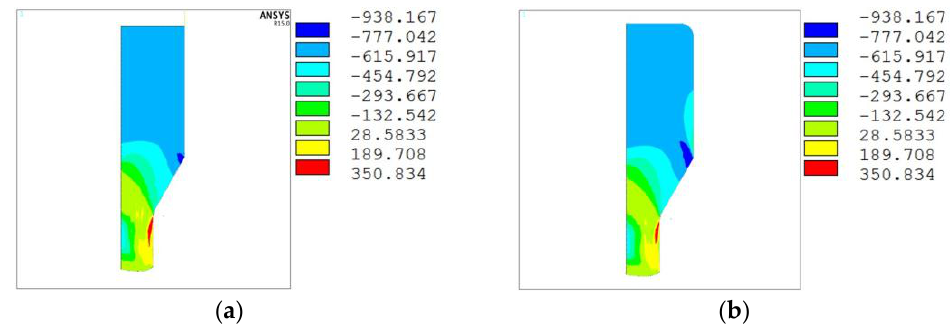
Figure 5. Axial distribution of ( a ) displacement-load model and ( b ) pressure-load model.